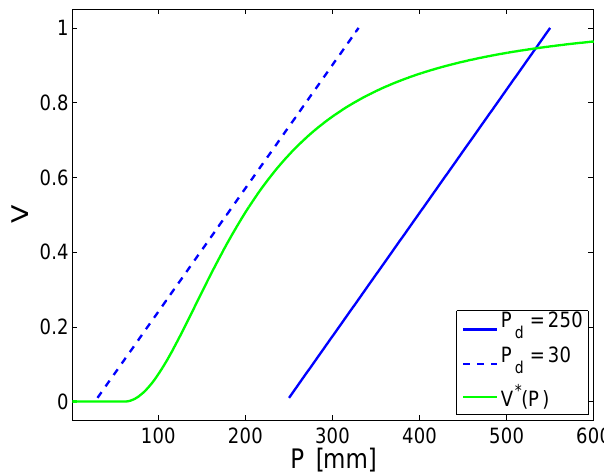
Fig. 1. Stability diagram for the one-dimensional conceptual model with k = 300. Blue lines: equilibrium precipitation P ∗ as calculated from P ∗ (V ) = P d + kV for different P d . Green line: equilibrium vegetation cover V ∗ (P) (Eq.